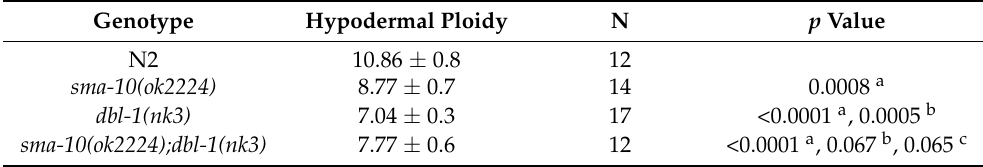
Table 1. Effect of mutations on hypodermal ploidy.